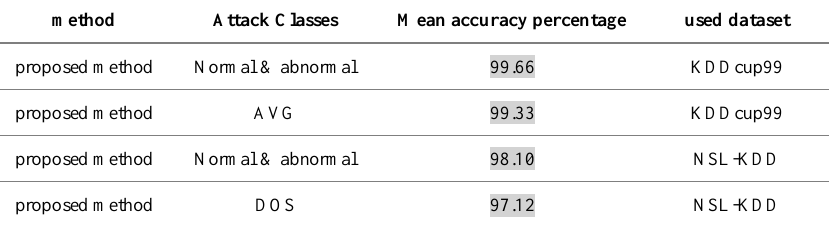
Table 4. Comparing other approaches and the proposed